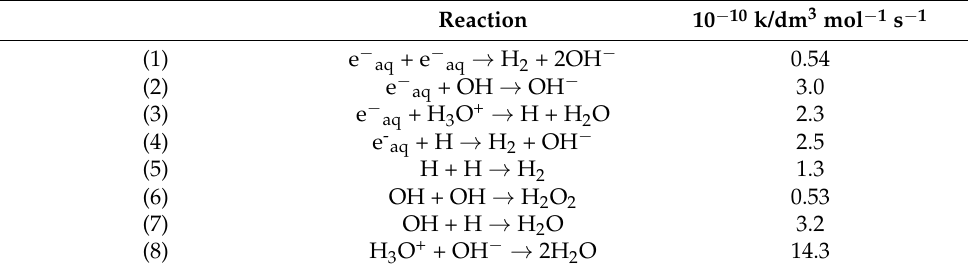
Figure 11. Envisioned sequence of initial events in the radiolysis of water. The superscript * indicates a radical species [37]. Table 4. Spur reactions in the radiolysis of water